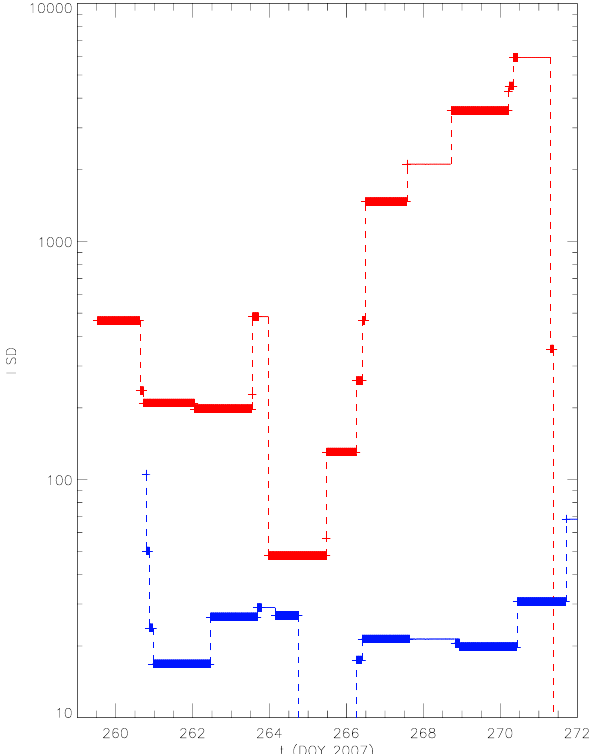
Figure 8. Phase space density at L = 6 . 0 (red) and L = 3 . 7 (blue) calculated from the observed fluxes, as functions of time, used as boundary conditions for radial diffusion simulations.